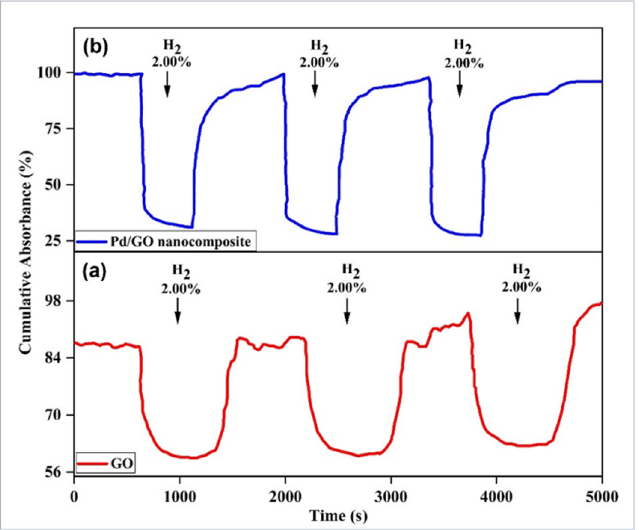
Figure 18. The repeatability of the developed sensor towards 2.00% concentration of H 2 in synthetic air at 100 °C ( a ) GO and ( b ) Pd/GO nanocomposite-based